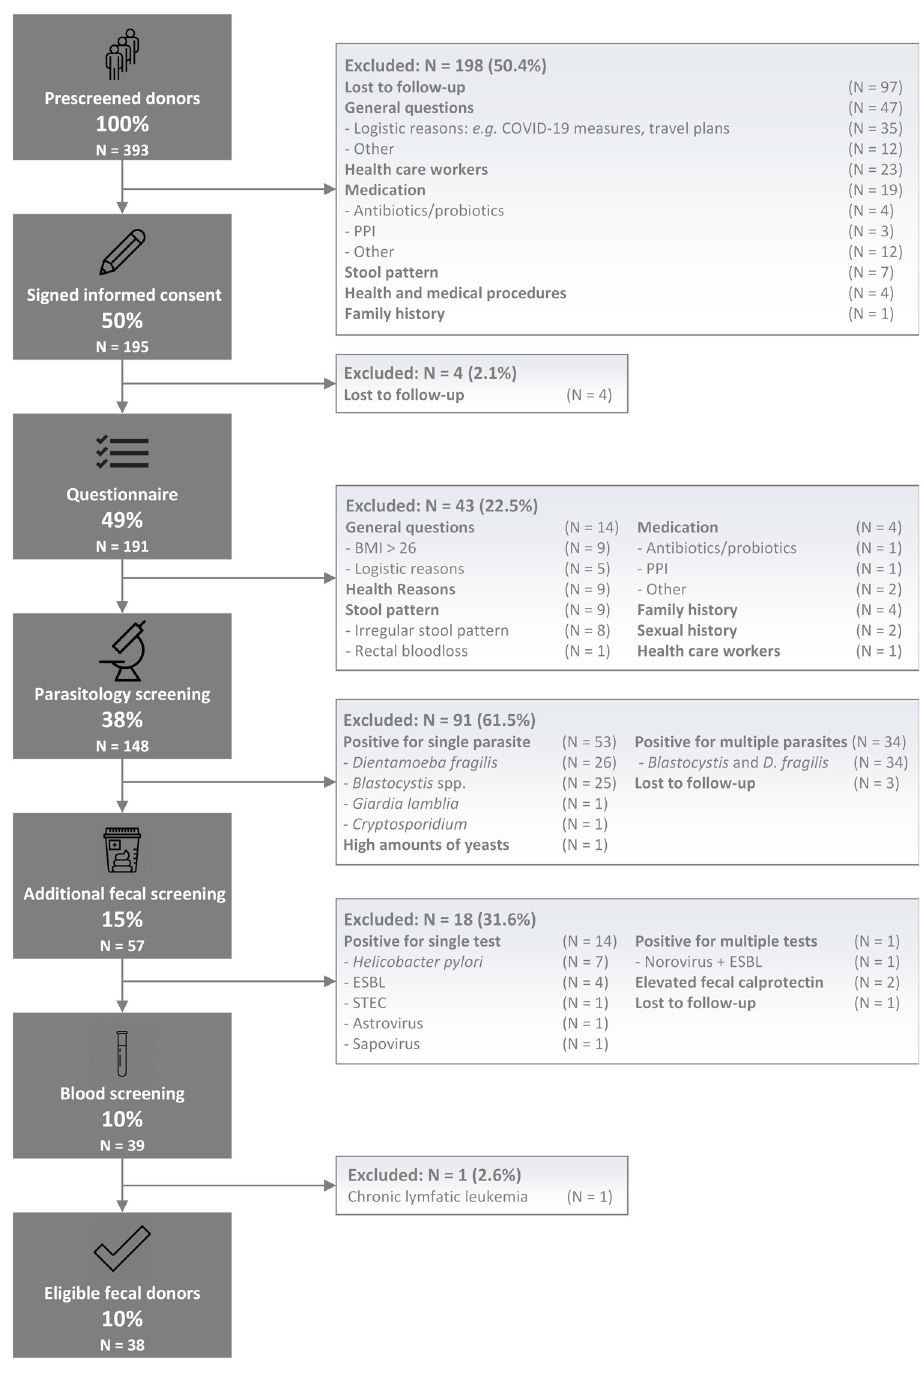
Fig 1. Flow diagram of donor screening